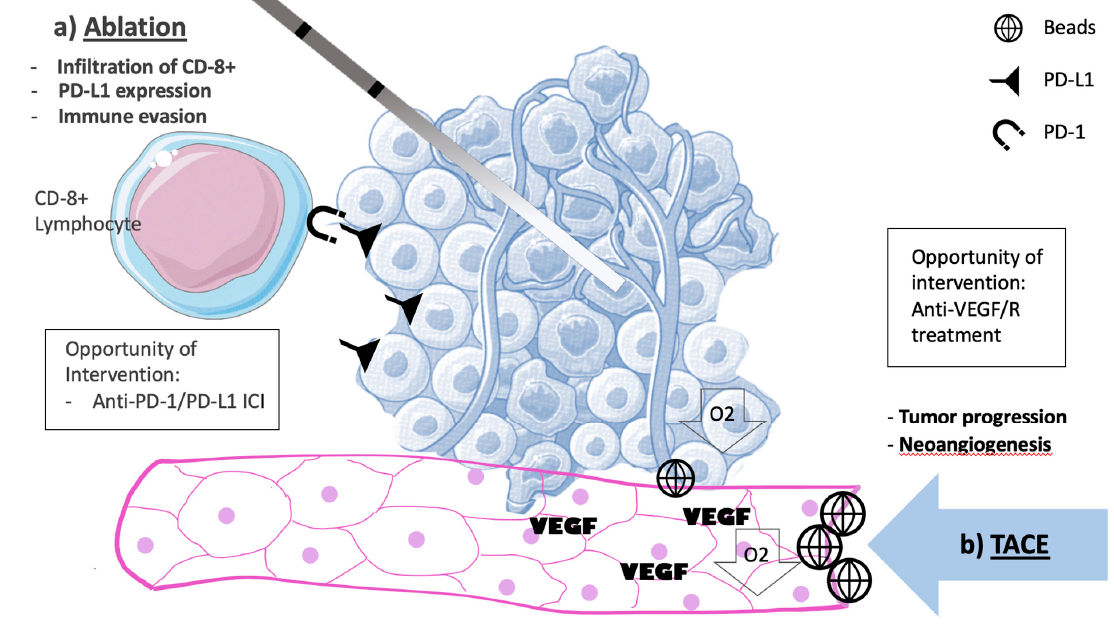
Figure 1. Liver directed therapies and changes in the tumor microenvironment. Increased vascular endothelial growth factor (VEGF) and neoangiogenesis with the potential for tumor progression after TACE; Infiltration of CD8 + Lymphocytes with resultant higher PD-L1 expression with the potential for tumor immune-evasion after ablation. RAF, radiofrequency ablation; TACE, transarterial chemoembolization; VEGF, vascular endothelial growth factor; VEGFR: vascular endothelial growth factor receptor.